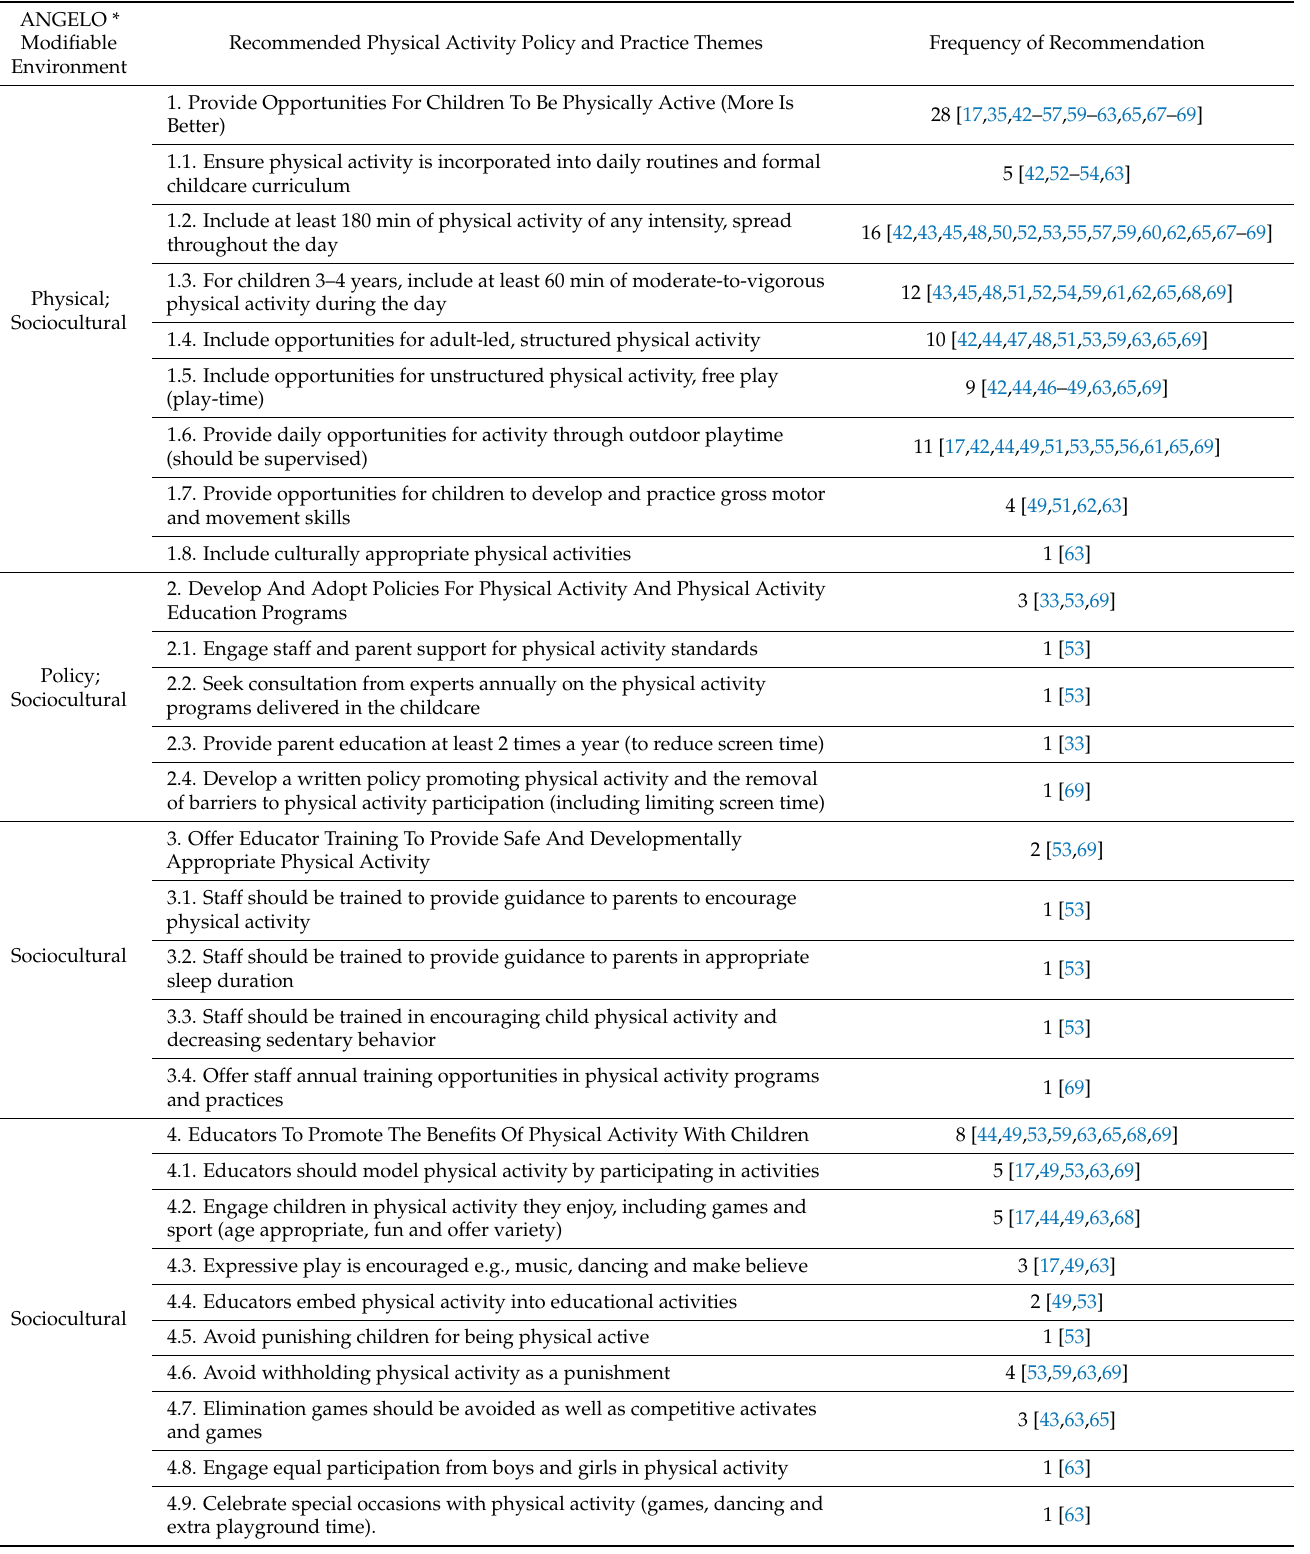
Table 3. Physical activity and sedentary behavior policies and practices within included guidelines ( n =